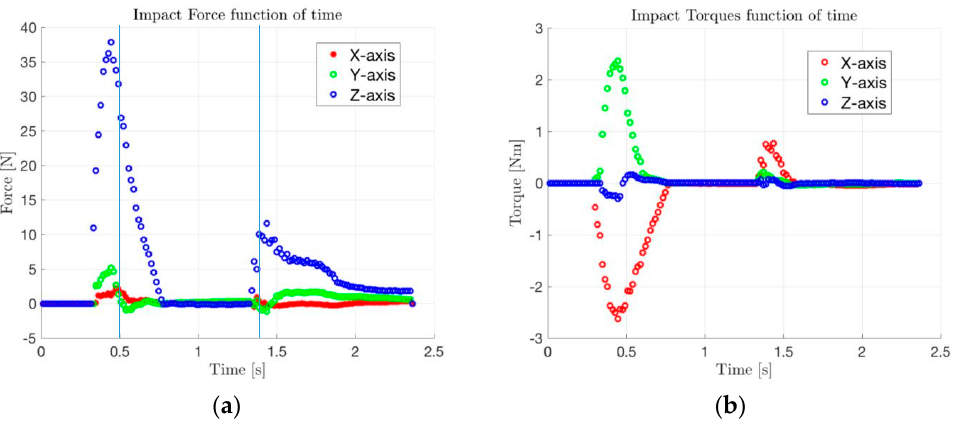
Figure 11. Nominal Case ( v = 0.030 m/s; β = 3 deg): ( a ) forces at impact and ( b ) torques at impact.